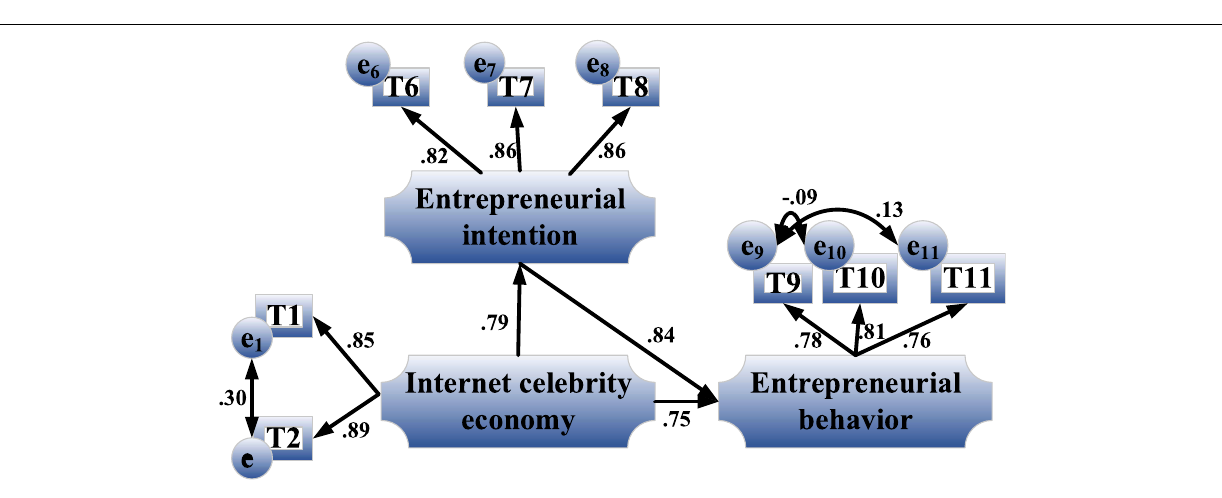
FIGURE 12 | Path coefficient diagram of the indirect impact of the Internet celebrity economy with entrepreneurial intention as a single mediating on entrepreneurial behavior.